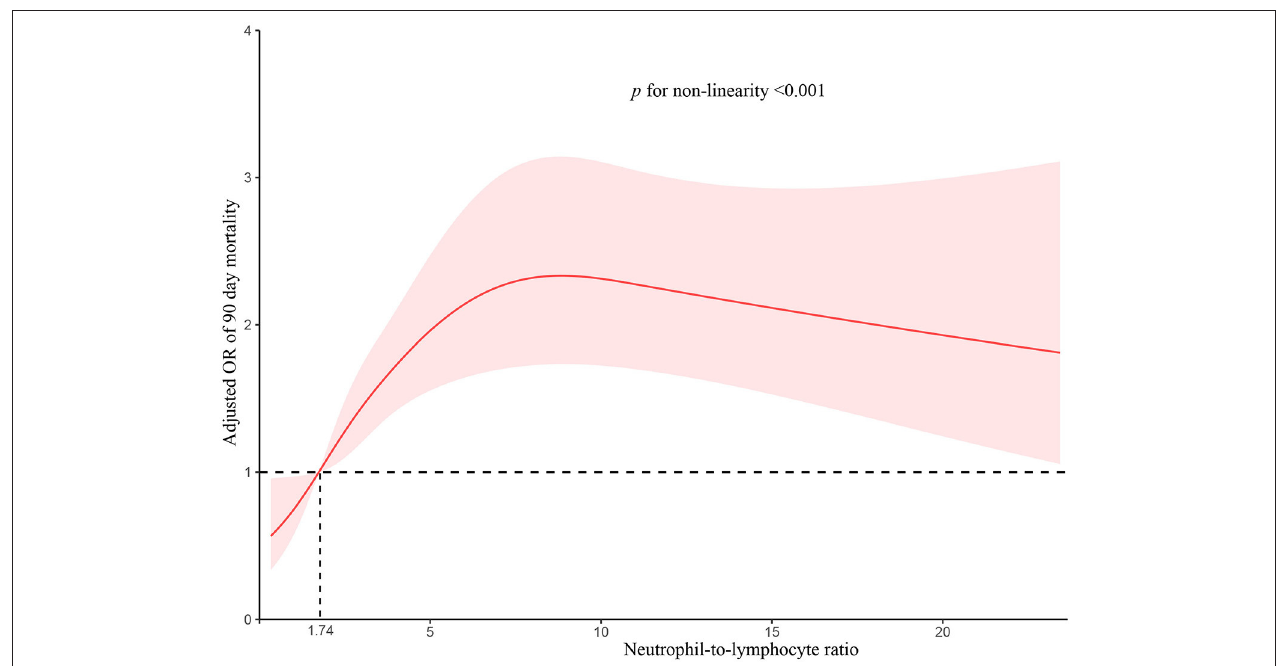
FIGURE 2 | Association of adjusted odds ratio between neutrophil-to-lymphocyte ratio and 90-day transplant-free mortality. The median NLR level within the lowest NLR quartile (1.74) served as the referent value (odds = 1.0). The model was adjusted for age; gender; etiology (HBV, alcohol, autoimmune); cirrhosis; hepatic encephalopathy grades, infection, ascites, gastrointestinal bleeding; total bilirubin; international normalized ratio; serum creatinine. The solid red line represents the multivariable-adjusted odds of mortality as a function of the measured NLR level and 95% confidence intervals are indicated by shaded areas. The p -values for non-linearity were < 0.001. NLR, neutrophil-to-lymphocyte ratio.